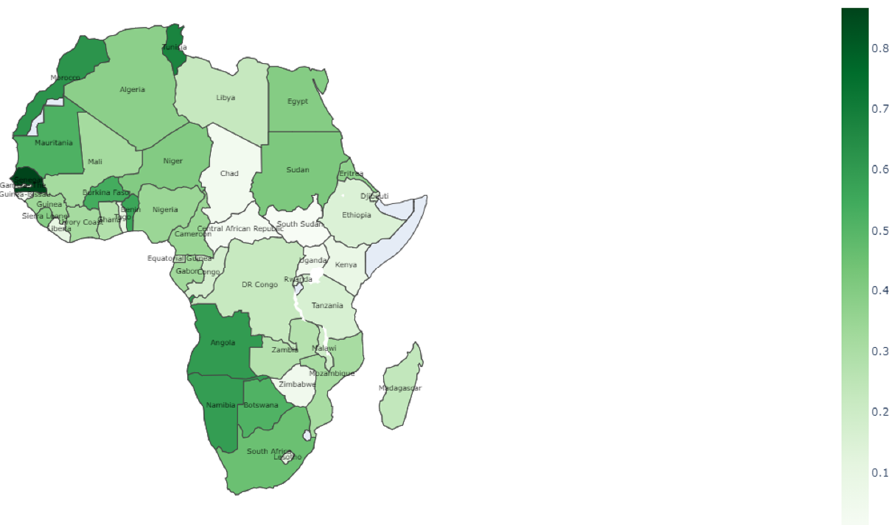
Figure 4. Cumulative results for values of synthetic sustainable growth indices for the studied African countries in 2010–2018—a model to substantiate standardization, which included the division of all terms in the series by arithmetic means for all values in the series (b). Source: own work.